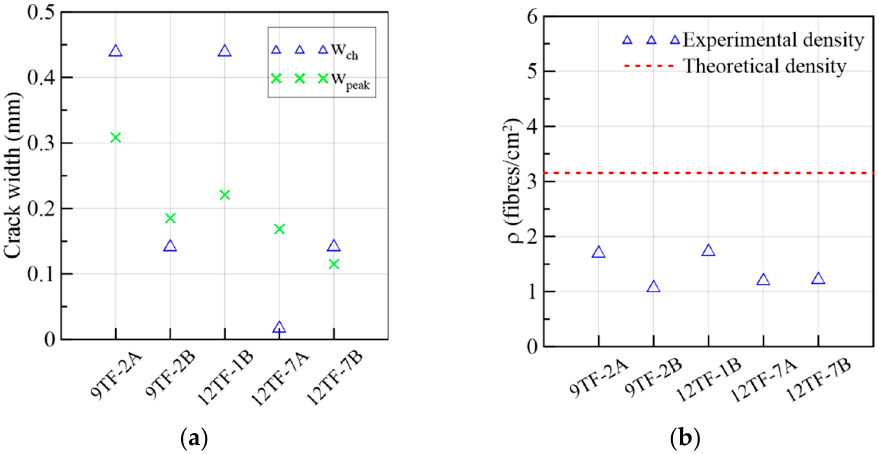
Figure 22. Mechanical results of 9TF-12TF specimens of the longitudinal direction: ( a ) crack widths at the change in behavior and at the peak load and ( b ) fiber densities.